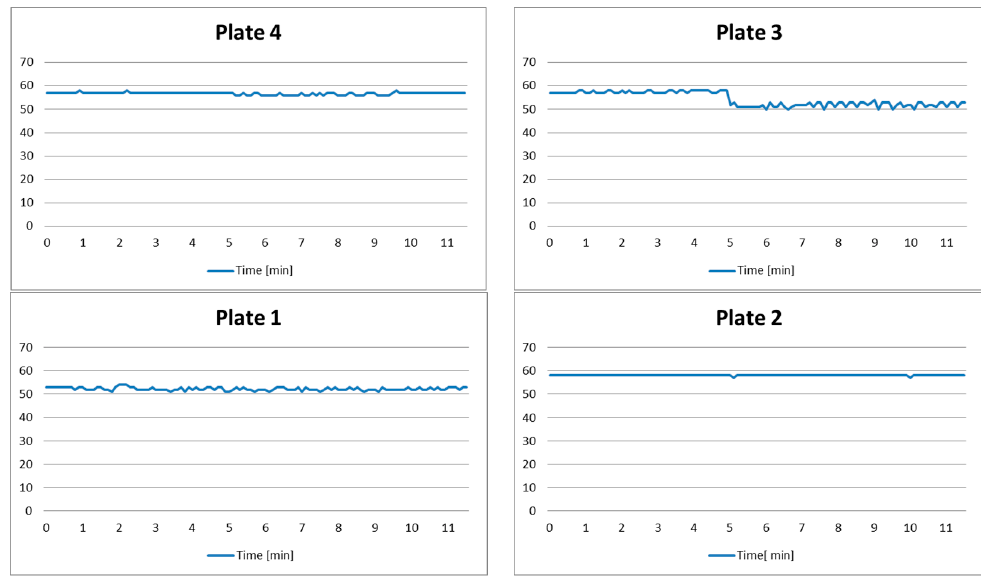
Figure 6. Test results of Scenario 2.